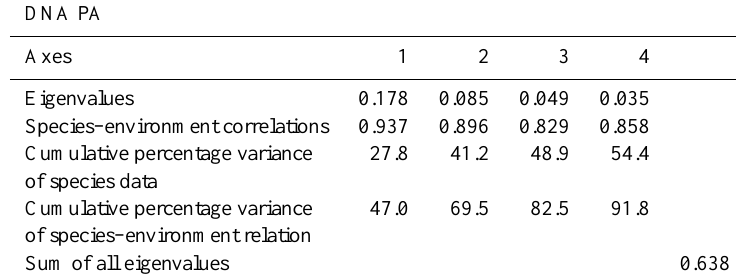
Table 3. Results of canonical correspondence analyses (CCAs). PA: particle-attached. FL: free-living. DNA PA